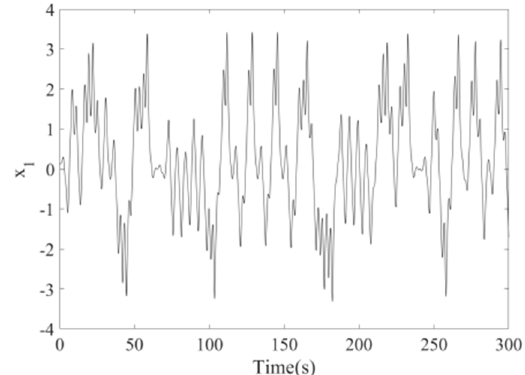
Figure 1. The time response of x 1 about ship parametric excitation rolling system Equation ( 18 ) .